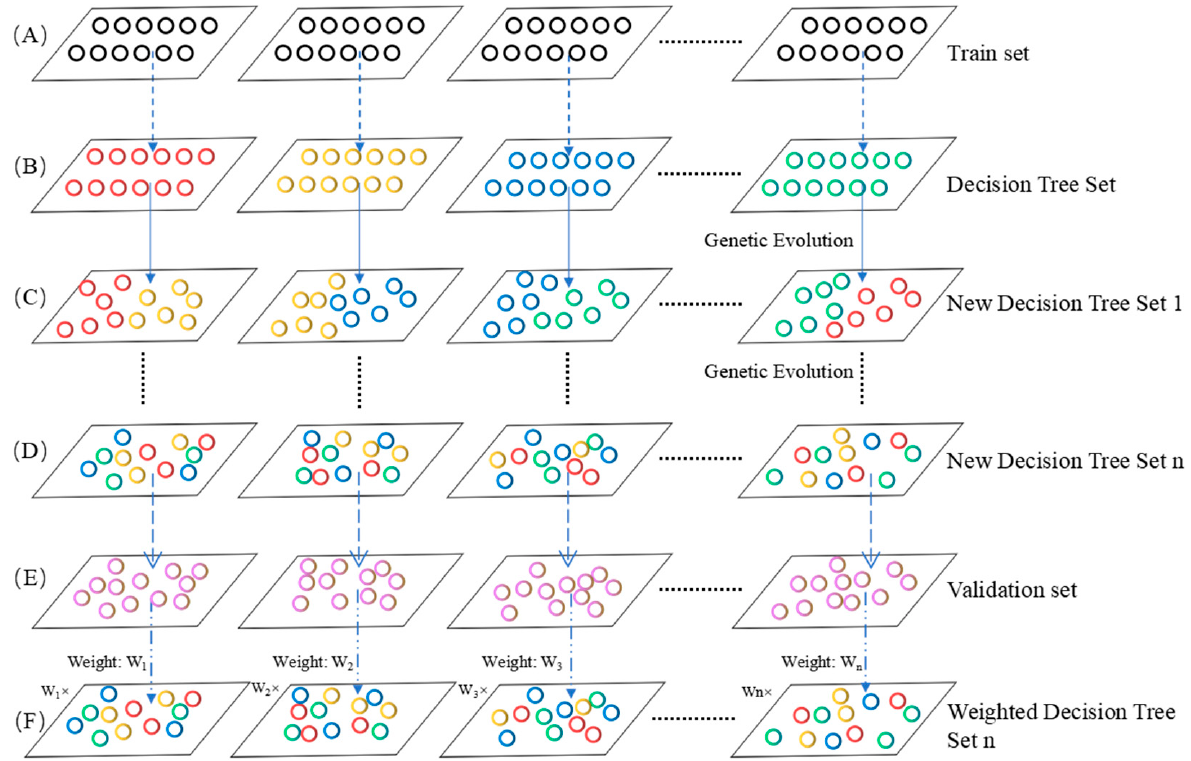
Figure 3. The workflow of genetic weighted random forest. ( A ) The training set. ( B ) The decision tree set constructed using the train set. ( C ) The new decision tree set after genetic evolution for once. ( D ) The new decision tree set after genetic evolution for n times. ( E ) The calculation of weight of each decision tree in validation set. ( F ) The weighted decision tree using the weight from E.